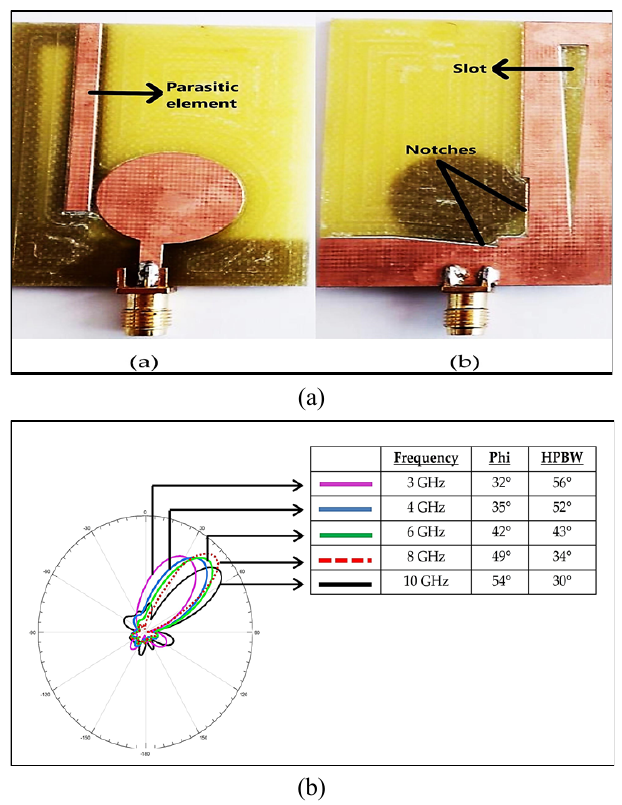
FIGURE 1. a) Front and back view of the PCDMA proposed in [9], b) Beam variation versus frequency for the proposed